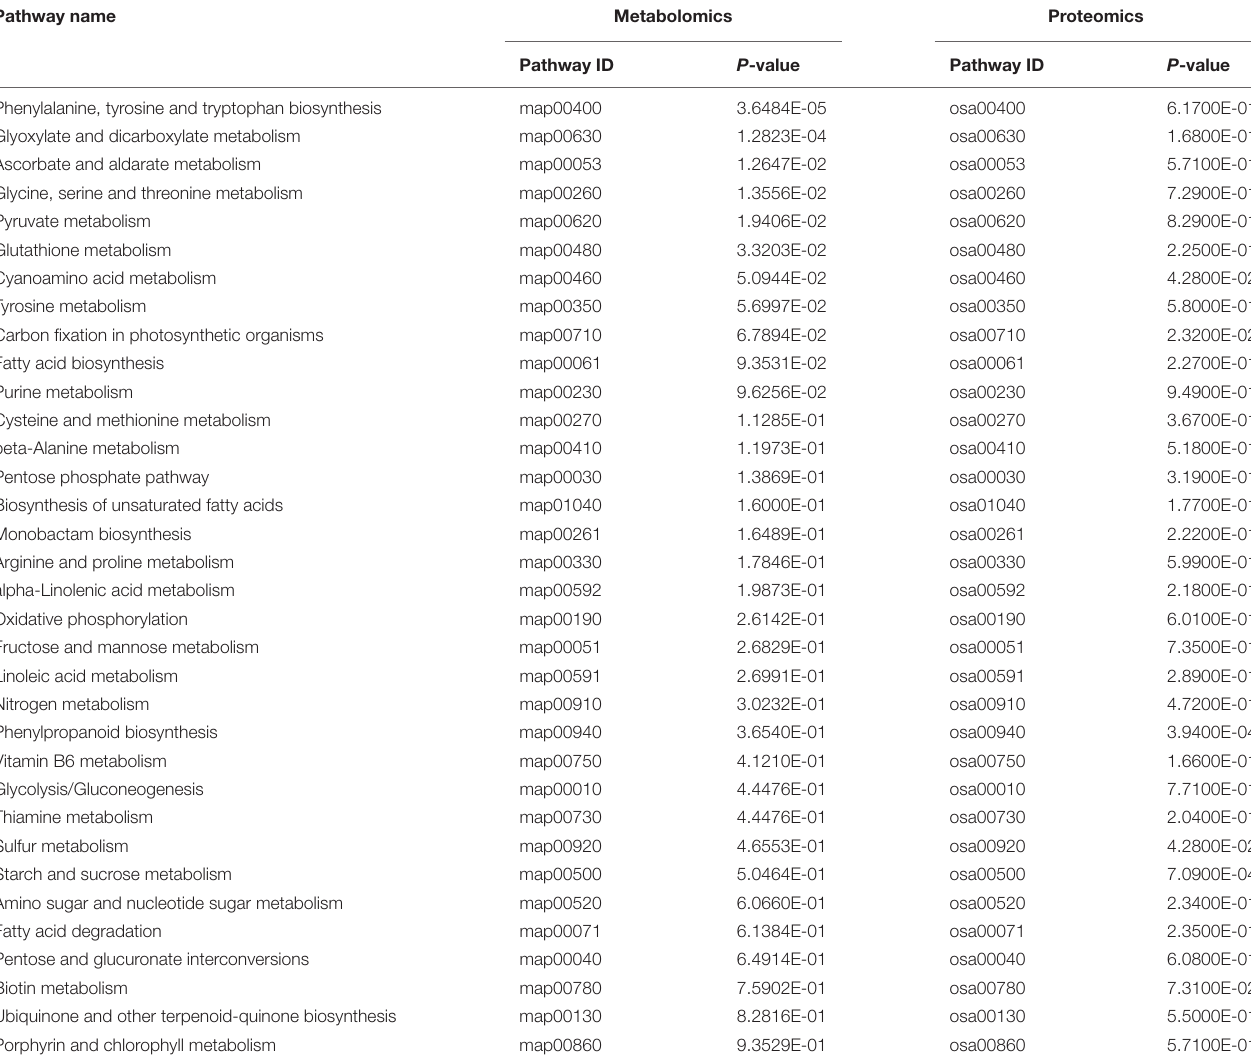
TABLE 1 | Proteins and metabolites involved in common pathways at